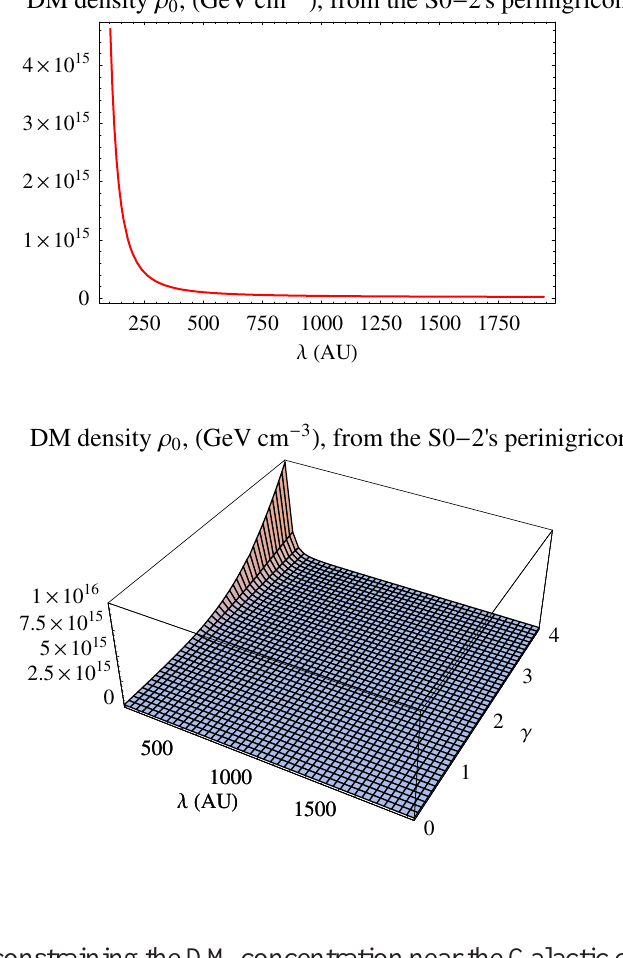
Figure 4. Upper bounds, in GeV cm − 3 (1 GeV cm − 3 is equivalent to 1 . 78 10 − 24 g cm − 3 ), × on the DM density parameter ρ 0 in the Sgr A ∗ —S0-2 system as a function of λ (top panel) of Equation (5), and of λ and γ of Equation (11) (bottom panel). The characteristic length λ , in AU, is assumed to vary from r min = a (1 e ) to r max = a (1 + e ) . A conservative − perinigricon rate uncertainty of 0 . 6 ◦ year − 1 was assumed for S0-2. It was compared with the theoretical predictions of Equation (8) (top panel) and of Equation (13) (bottom